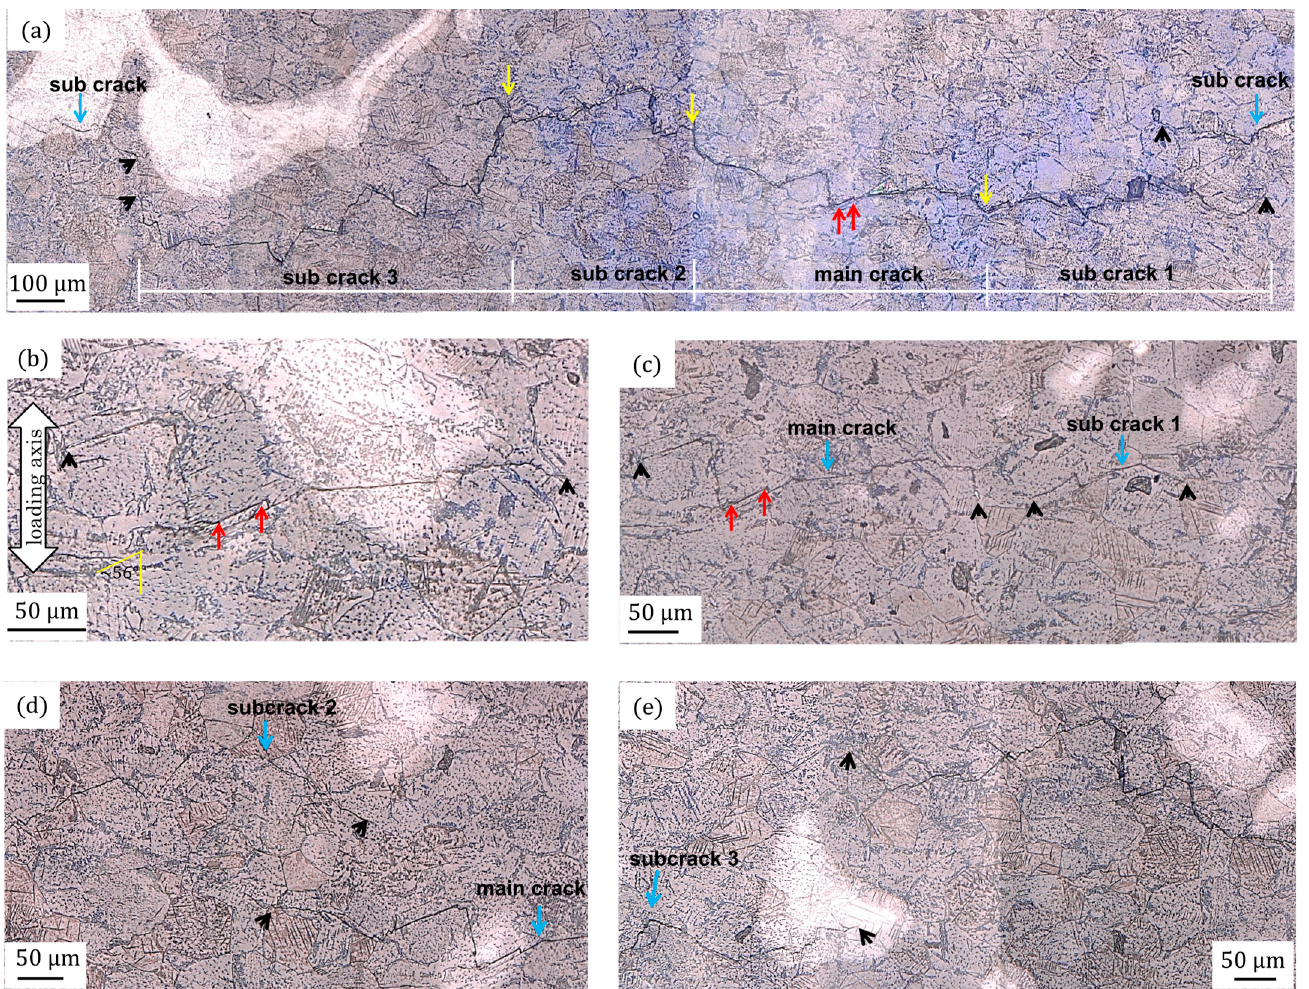
Figure 4. At 227 MPa: Images displaying crack paths at different cycles. After ( a ) N = 1 × 10 5 cycles; ( b ) N = 0.4 × 10 5 cycles; ( c ) N = 0.5 × 10 5 cycles; ( d ) N = 0.7 × 10 5 cycles; ( e ) N = 0.9 × 10 5 cycles. Red arrows show the crack initiation line, while black arrows indicate crack tips; ( c ) shows the main crack and sub ‐ crack 1 before coalescing, while the main crack and sub ‐ crack 2 can be seen in ( d ); ( e ) shows the main crack and sub ‐ crack 3 prior to coalescence. The yellow arrows in ( a ) indicate the junctions of crack coalescence.